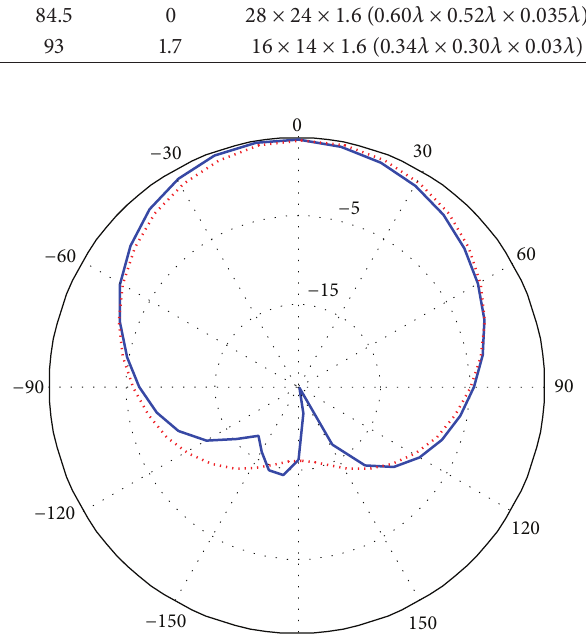
Figure 8: Radiation pattern of the antenna in Figure 7 at 6.36 GHz; solid line is for the E-plane ( 𝑋𝑍 ) and dashed line is for the H-plane; the realized gain (dBi) is plotted.